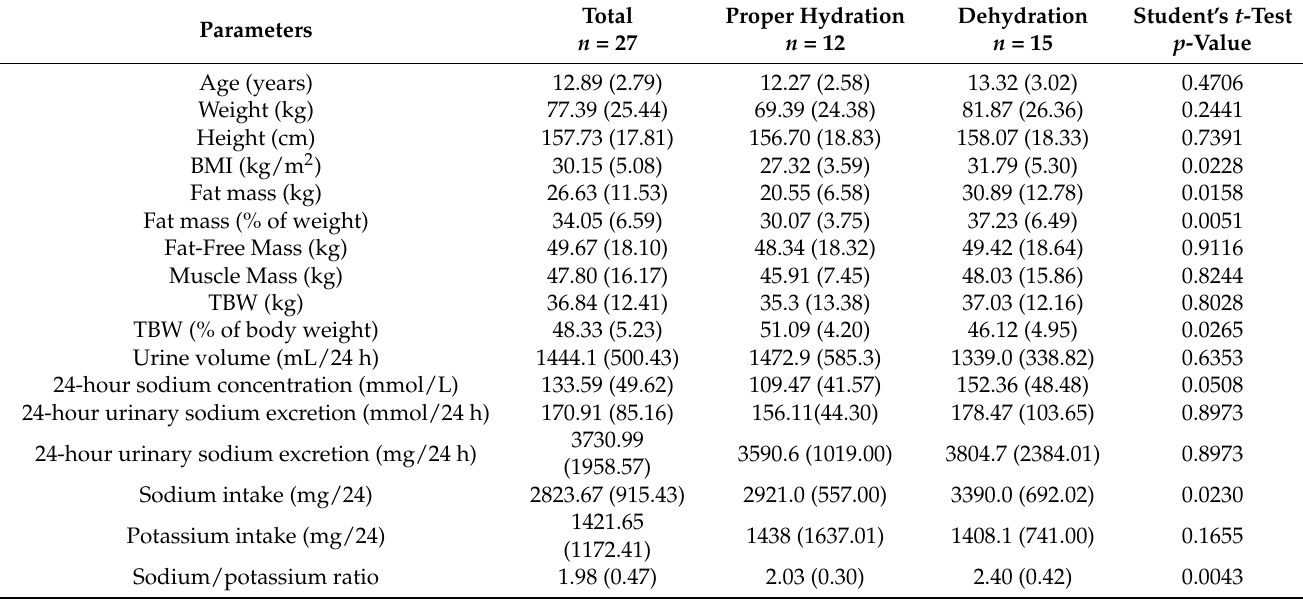
Table 4. Differences in body composition, urine tests, and sodium and potassium intake, depending on hydration status.